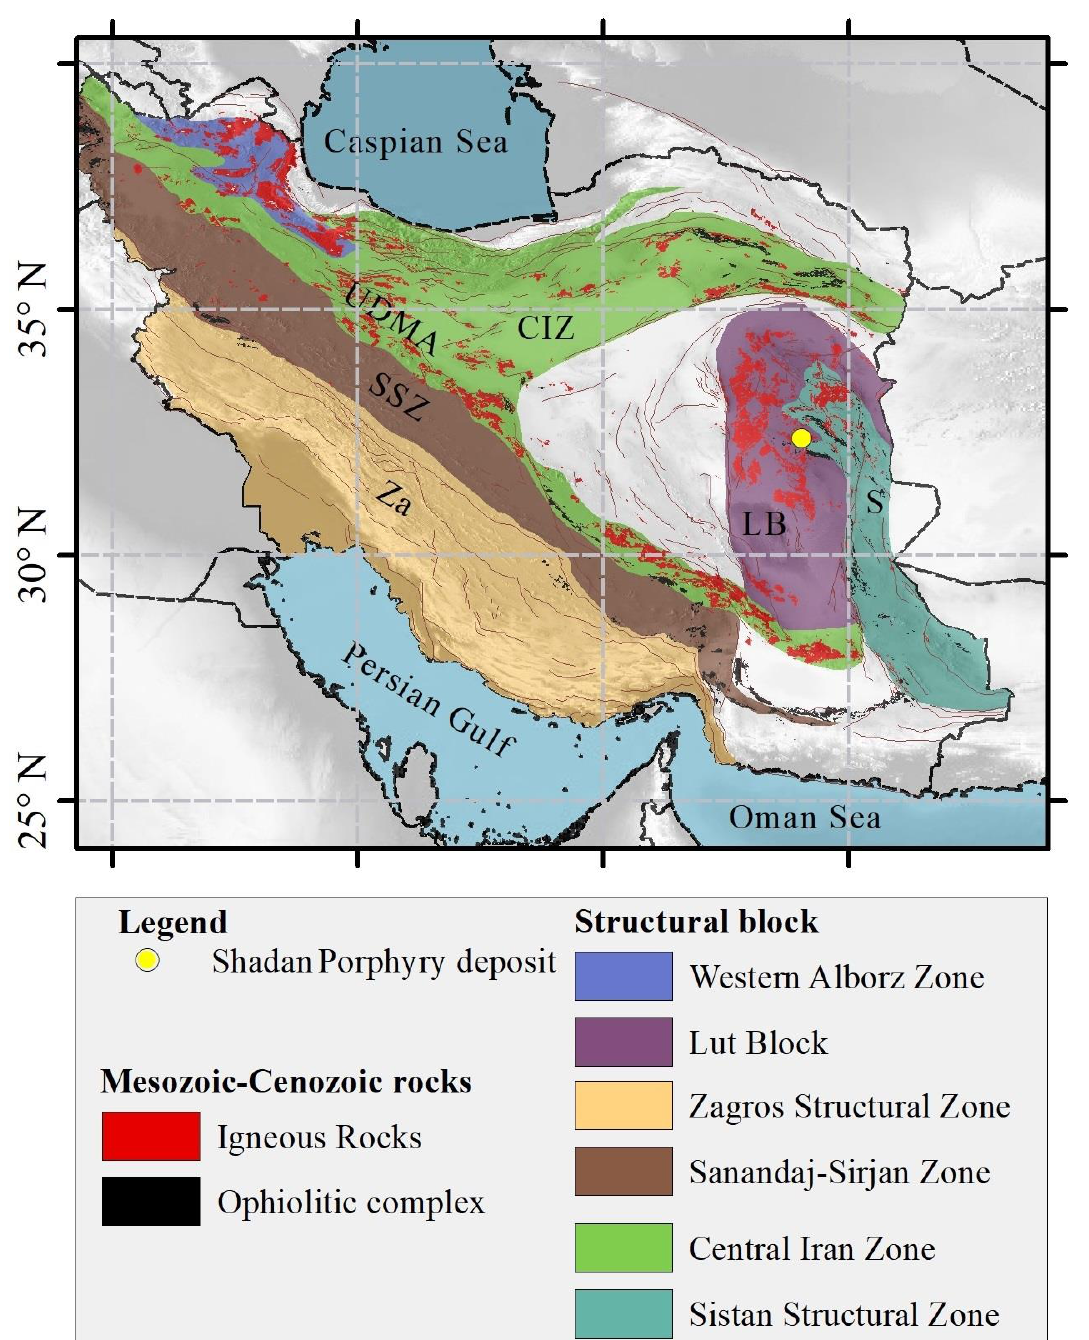
Figure 1. Location of key porphyry deposits on lithologic structural map of